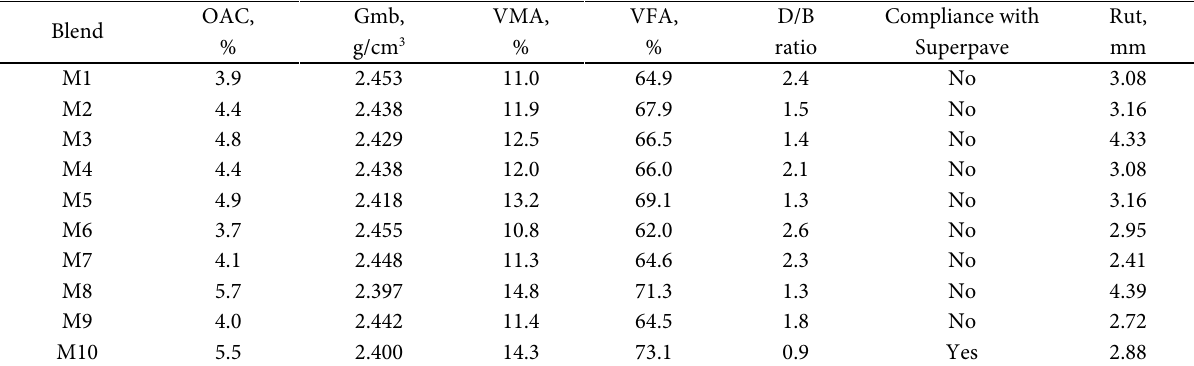
Table 5. The properties of Superpave mixtures and APA results